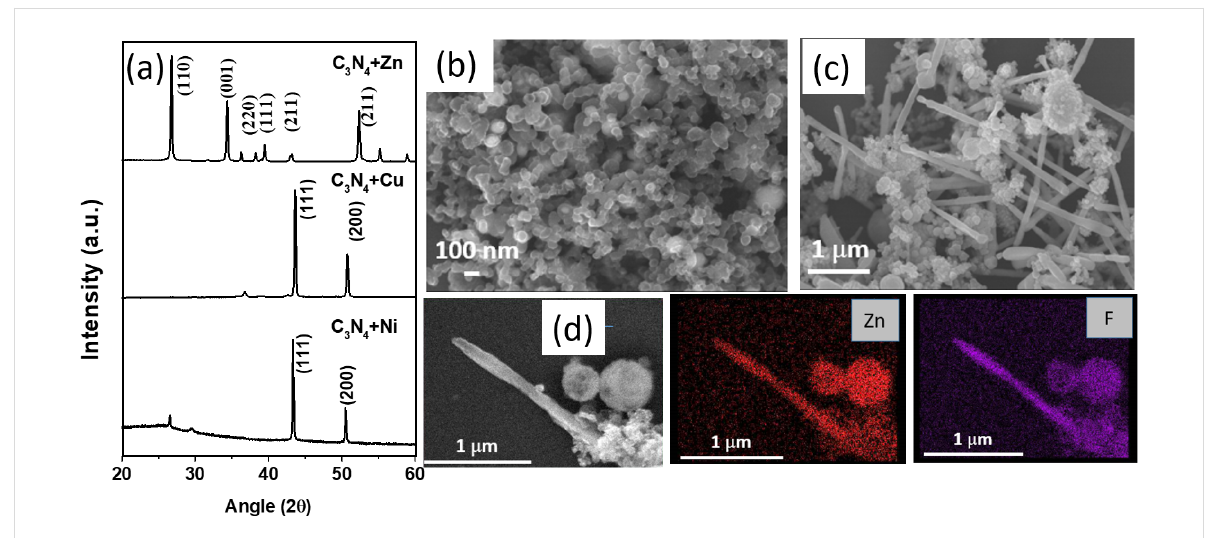
Figure 3: (a) XRD patterns of carbon-coated Cu and Ni nanoparticles and ZnF 2 nanorods. (b) SEM images of carbon-coated Cu nanoparticles. (c) SEM images of ZnF 2 nanorods. (d) SEM image and EDS elemental mapping of a single ZnF 2